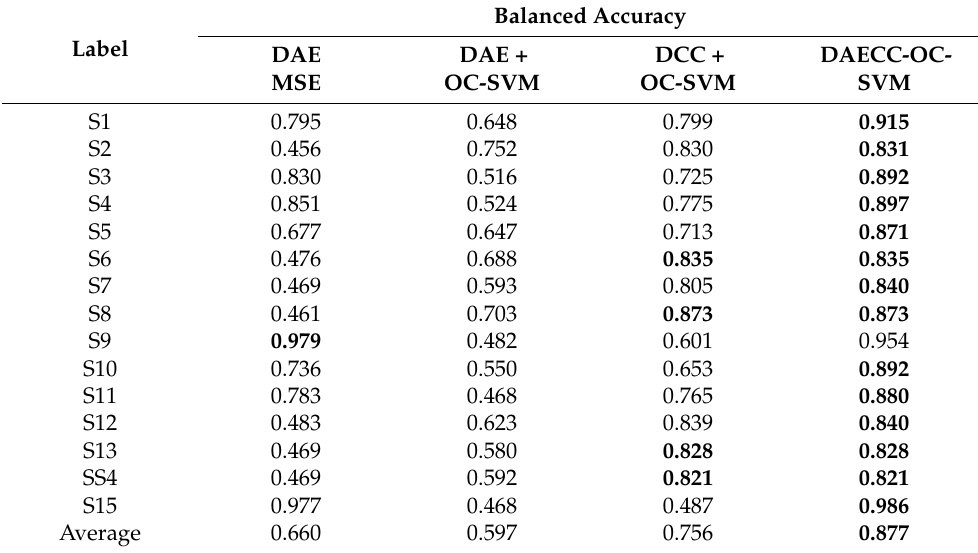
Table 4. Average balanced accuracy over 15 experimental scenarios with different methods.